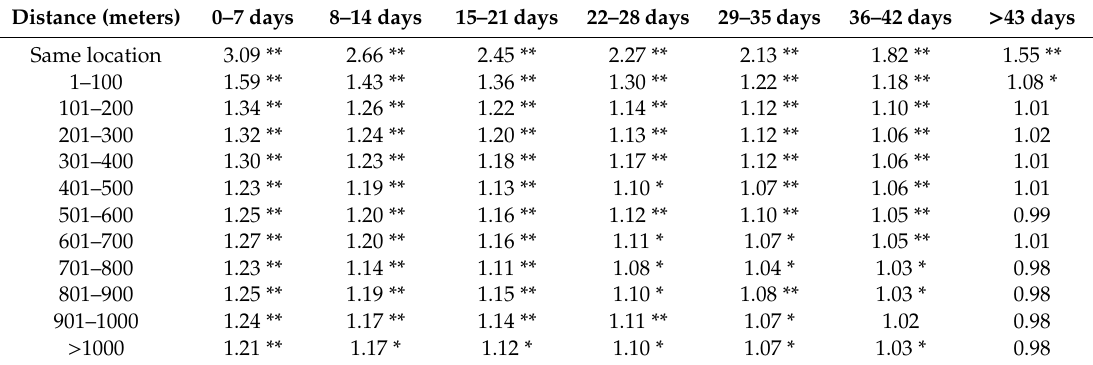
Table 1. Repeat and near-repeat (RNR) matrix of PP.